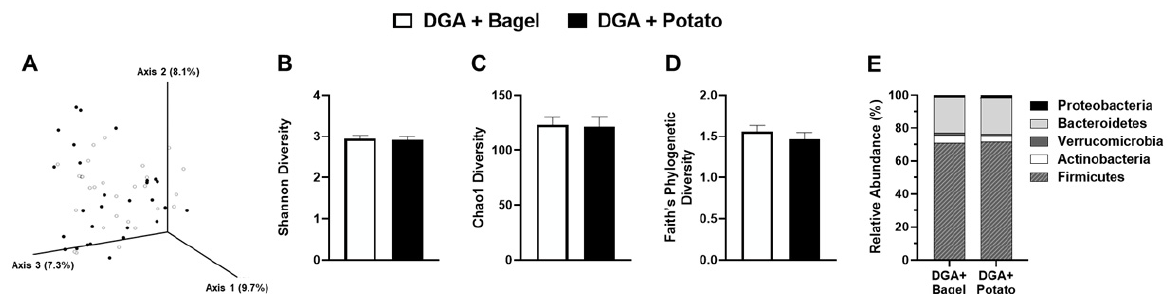
Figure 5. Gut microbial diversity and relative abundance in fecal samples collected from MetS persons who followed a Dietary Guidelines for Americans -based diet containing potatoes (DGA + POTATO) or bagels (DGA + BAGEL) for 2 w. ( A ) Principal component analysis of Bray-Curtis dissimilarity ( β -diversity), and ( B ) Shannon, ( C ) Chao1, and ( D ) Faith’s Phylogenetic Diversity indexes of α -diversity were determined. ( E ) Relative abundance of phylum level bacteria populations. Group separation ( β -Diversity) was tested by permutational multivariate analysis of variance (PERMANOVA). No statistically significant between-treatment effects were observed for indices of α -diversity or the differential abundance at the phylum level ( p > 0.05).